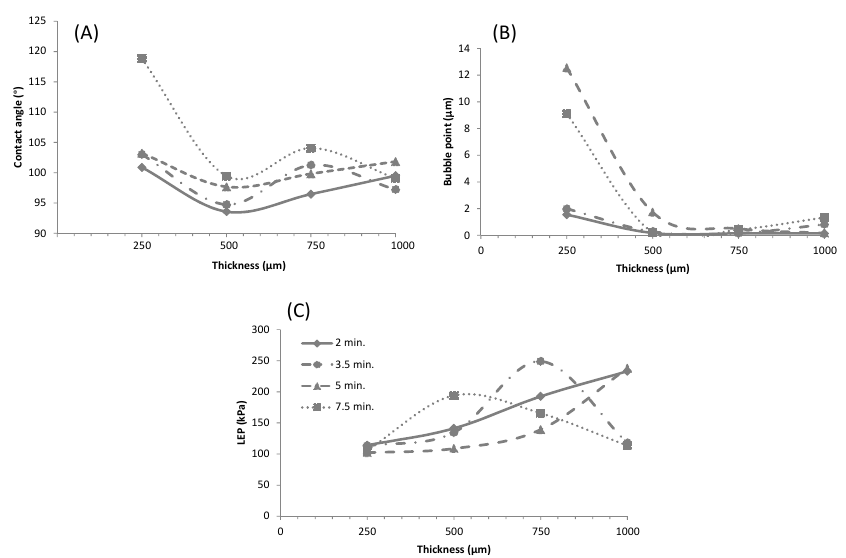
Figure 10. Impact of casting thickness on the properties of PVDF membrane prepared using VIPS process, all using 12% w / w PVDF polymer solution and under 80% RH. ( A ) Contact angle profile; ( B ) Bubble point profile; ( C ) LEP profile.